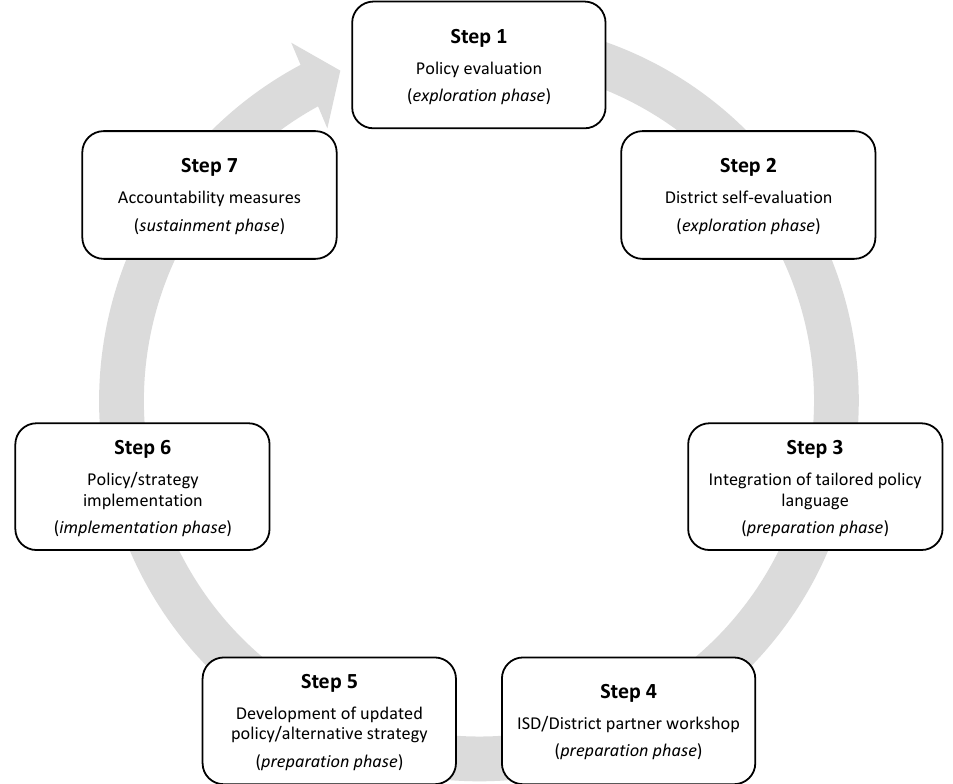
Figure 1. Seven-step policy evaluation, alignment, and enhancement process. ISD, intermediate school district.